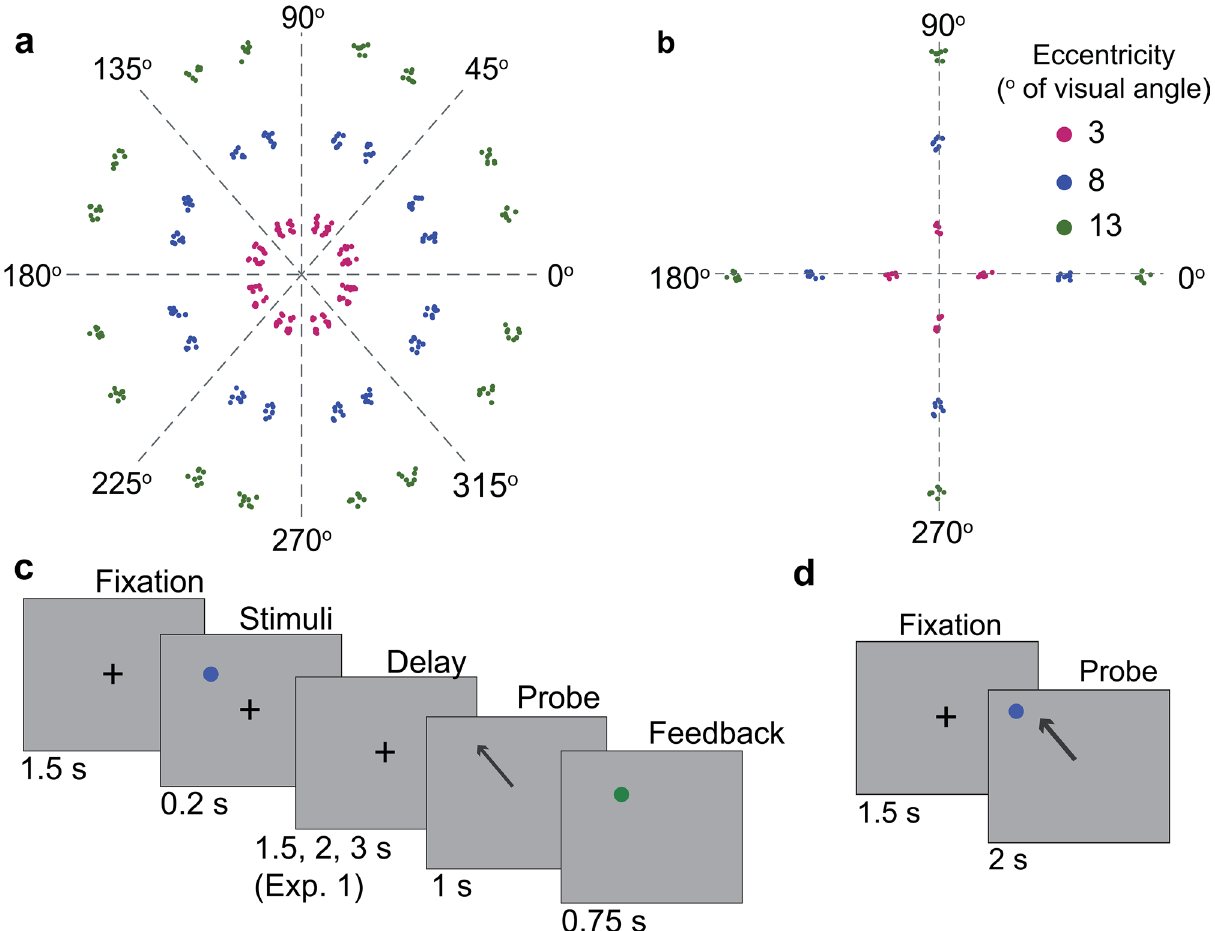
Figure 1. Experimental task design and stimuli. Distribution of visual stimuli across space in Experiment 1 ( a ) and Experiment 2 ( b ). Stimulus locations across trials are slightly jittered around the targets. Memory-guided saccade task ( c ) and visually guided saccade task ( d ). The arrows in ( c ) and ( d ) are shown to illustrate the memory-guided or visually guided saccade, which are not shown during the actual